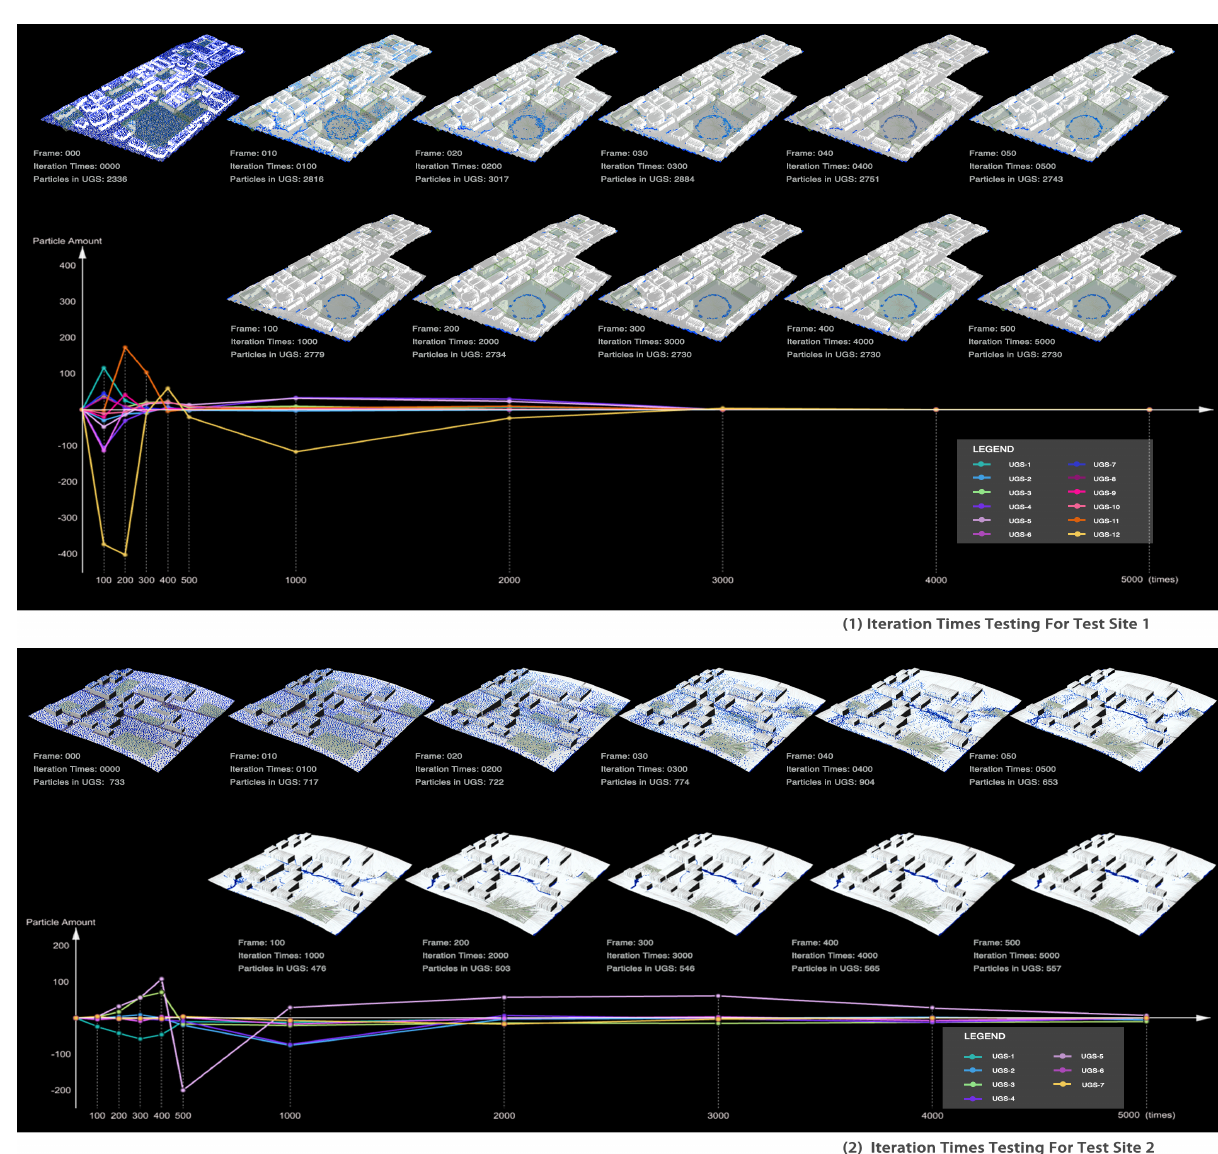
Figure 6. Simulation Result With Different Iteration